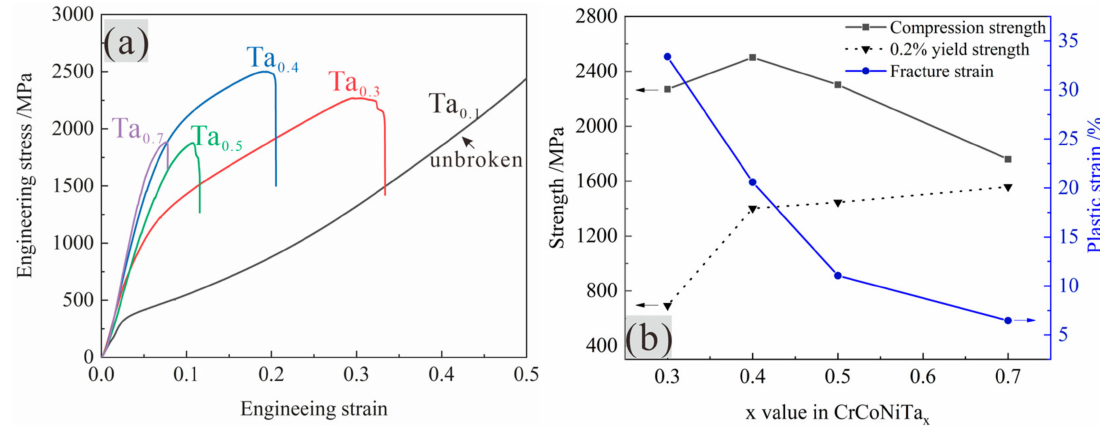
Figure 8. ( a ) Compression engineering stress-strain curves; ( b ) compression strength, 0.2% yield strength and fracture strain of CrCoNiTa x